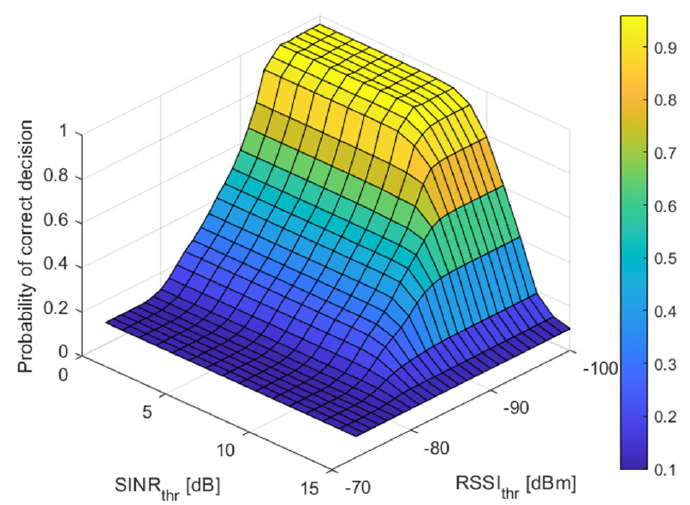
Figure 14. The probability of correct decision for different threshold values for RSSI and SINR while the threshold for RSRP was set to − 133 dBm and the threshold for RSRQ was set to − 17 dB.